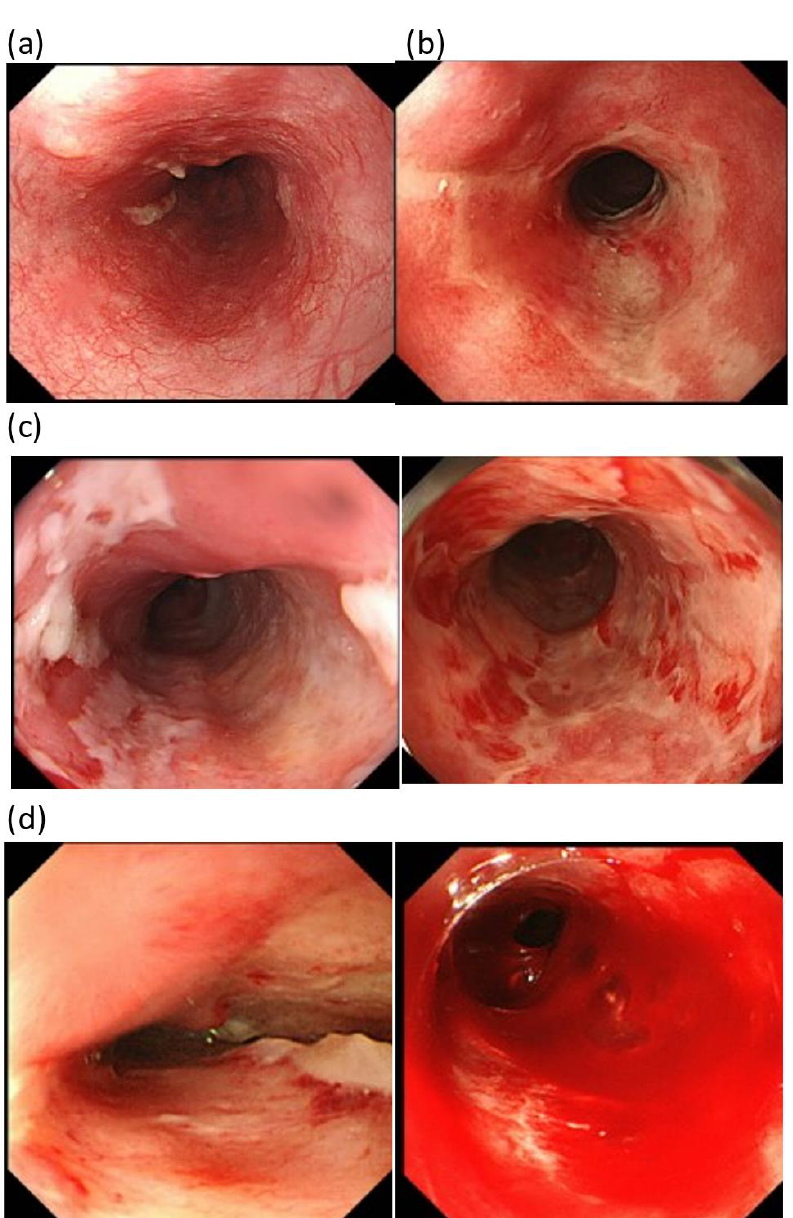
Figure 1. Radiation esophagitis grading using endoscopy (FARE grade). ( a ) Grade 1: mucosa with the erythema. ( b ) Grade 2: mucosa with erosion. ( c ) Grade 3: mucosa with a shallow ulcer and